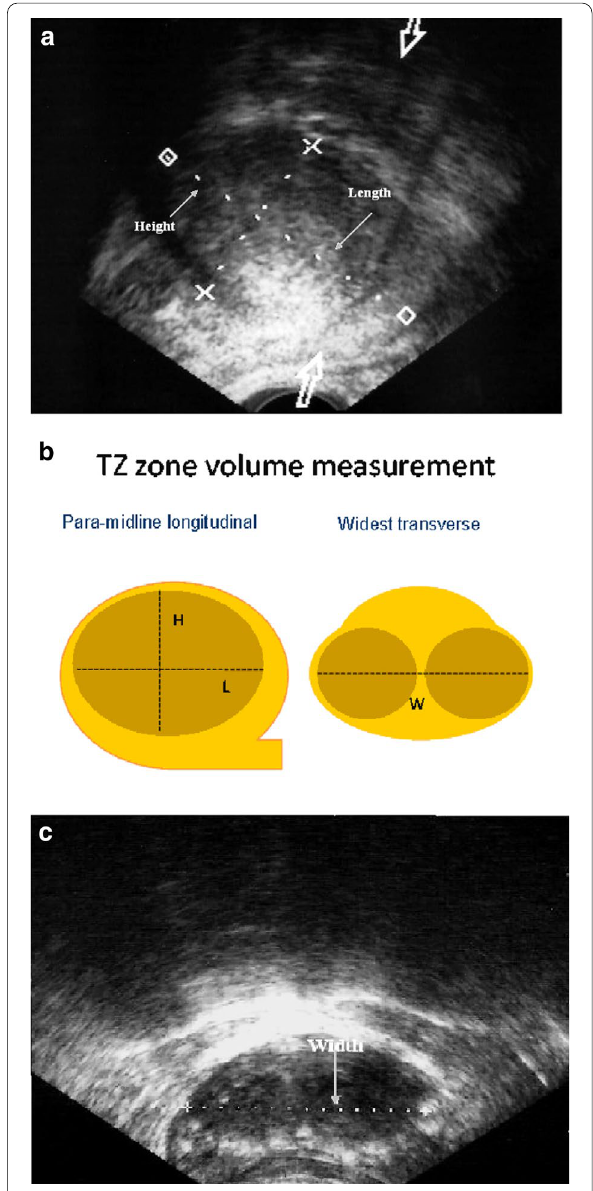
Fig. 2 TZ vol measurements in transverse and longitudinal views. A TZ vol measurement concept. B TZ vol measurement in longitudinal scanning. C TZ vol measurement in transverse